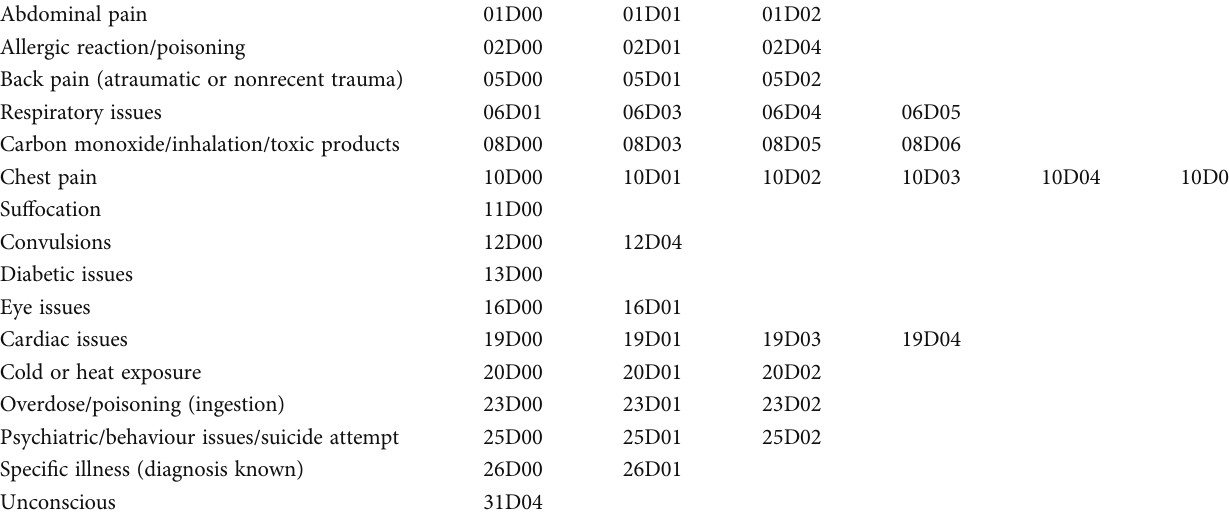
Table 2: Advanced Medical Priority Dispatch System (AMPDS) codes selected to use remote prehospital emergency physician support through telemedicine (tele-PHP) during this study. Abdominal pain